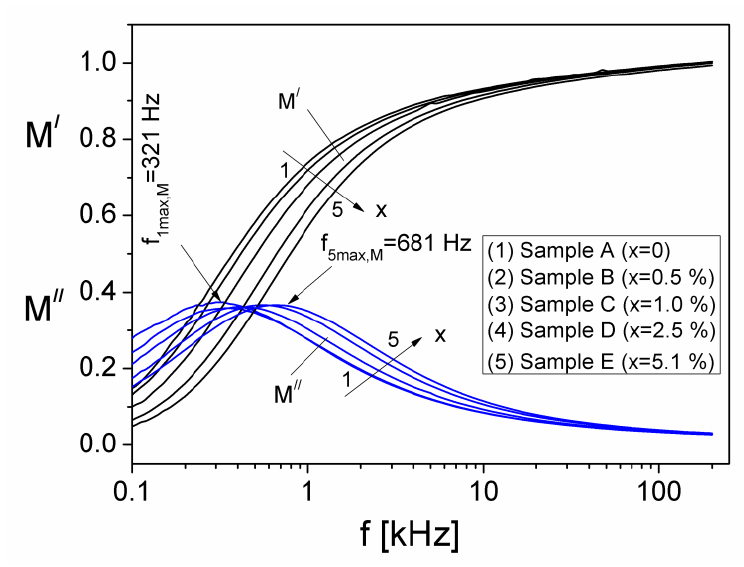
Figure 6. The frequency dependence of the real (M′) and imaginary (M′′) components of the electric modulus of the samples with different volume fractions, x of Al particles.